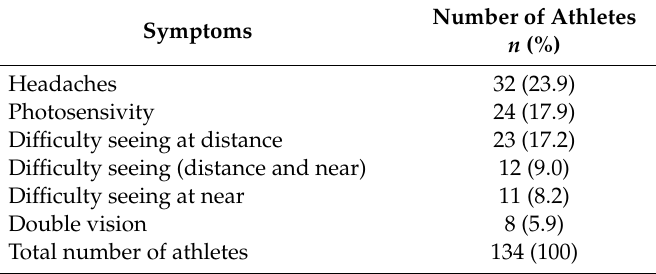
Table 3. Prevalence of reported symptoms.